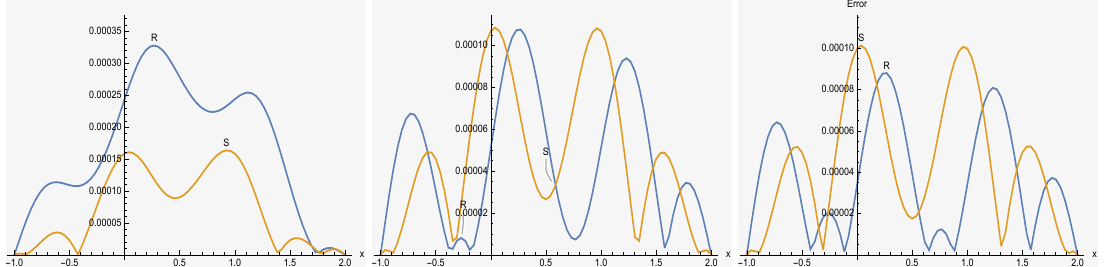
Figure 3. Computed approximation solutions of R and S in Equation (1) for α = 0.1, α = 0.01, α = 0.001, respectively, τ = 0.005, a = 1, b = 2, N = 78 and t = 1. −